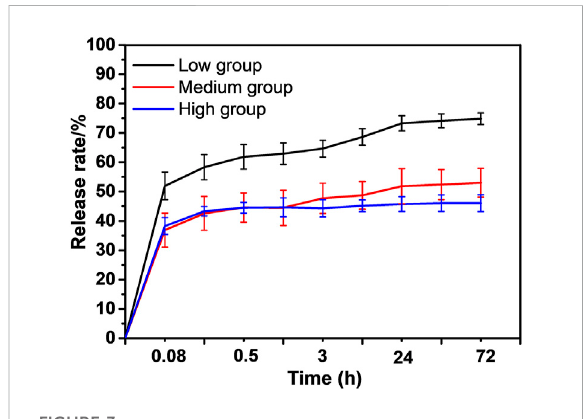
FIGURE 3 The in vitro paclitaxel release pattern of the experimental groups.